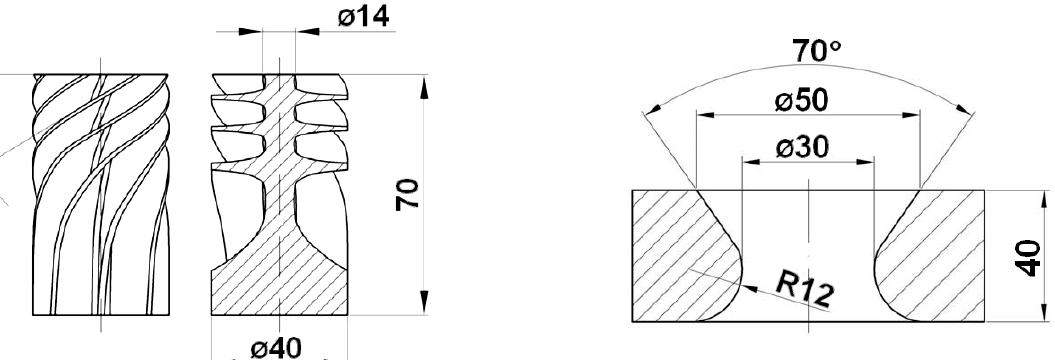
Figure 1. The swirler and the nozzle geometry.